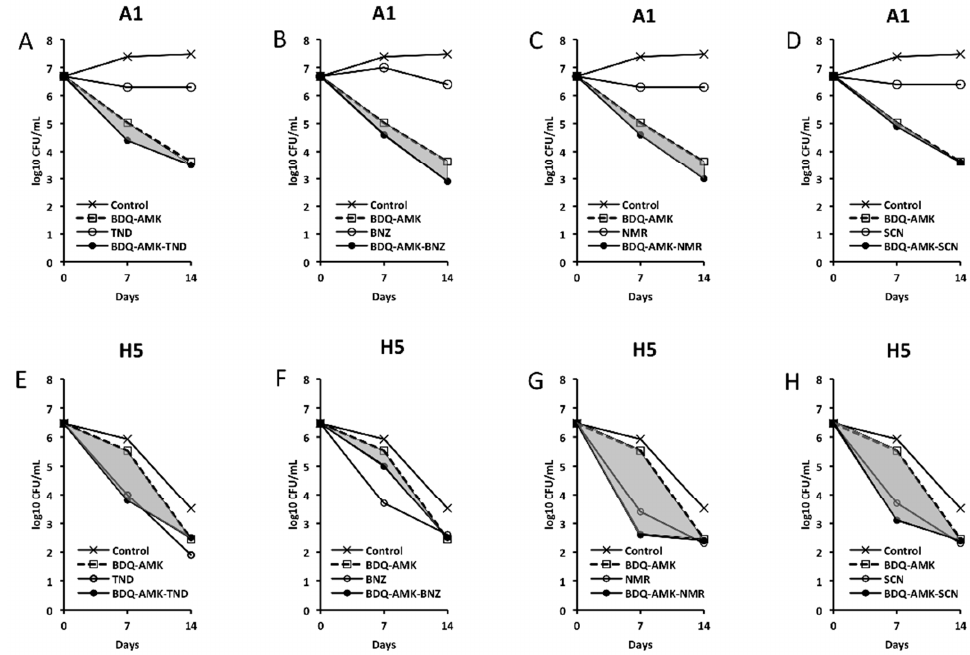
Figure 5. Activity against A1 and H5 cells of 3-drug combinations containing bedaquiline-amikacin (BDQ-AMK). ( A , E ) BDQ-AMK ± tinidazole (TND); ( B , F ) BDQ-AMK ± benznidazole (BNZ); ( C , G ) BDQ-AMK ± nimorazole (NMR); ( D , H ) BDQ-AMK ± secnidazole (SCN). Increases in the activities of (BDQ-AMK + third drug) versus BDQ-AMK are highlighted in grey.